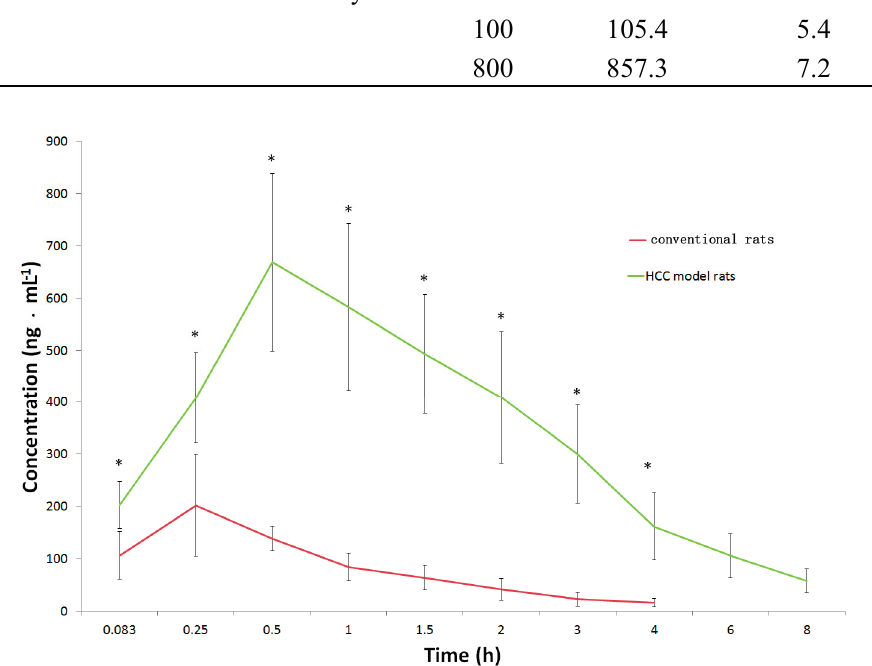
Figure 2. Mean plasma concentration-time profiles of caudatin after oral administration at a dose of 20 mg/kg in conventional and HCC rats. Significantly different from the conventional rats (*, p <